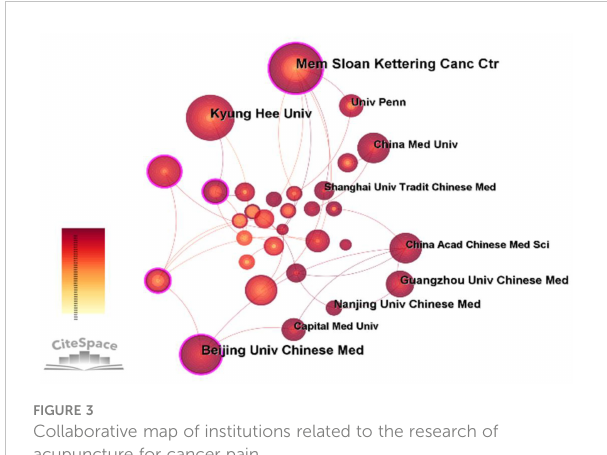
FIGURE 3 Collaborative map of institutions related to the research of acupuncture for cancer